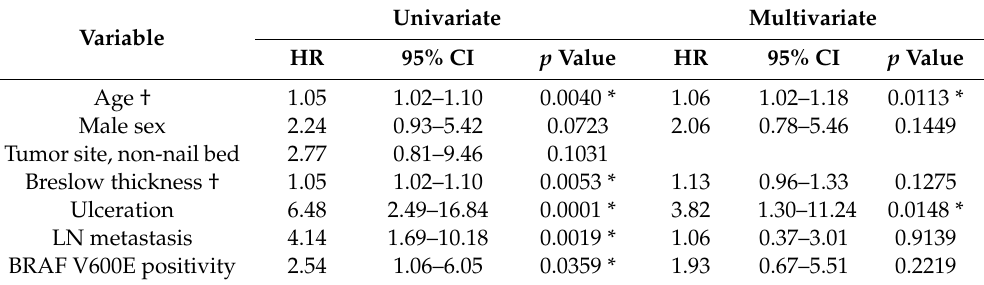
Table 4. Cox multivariate analysis for melanoma-specific